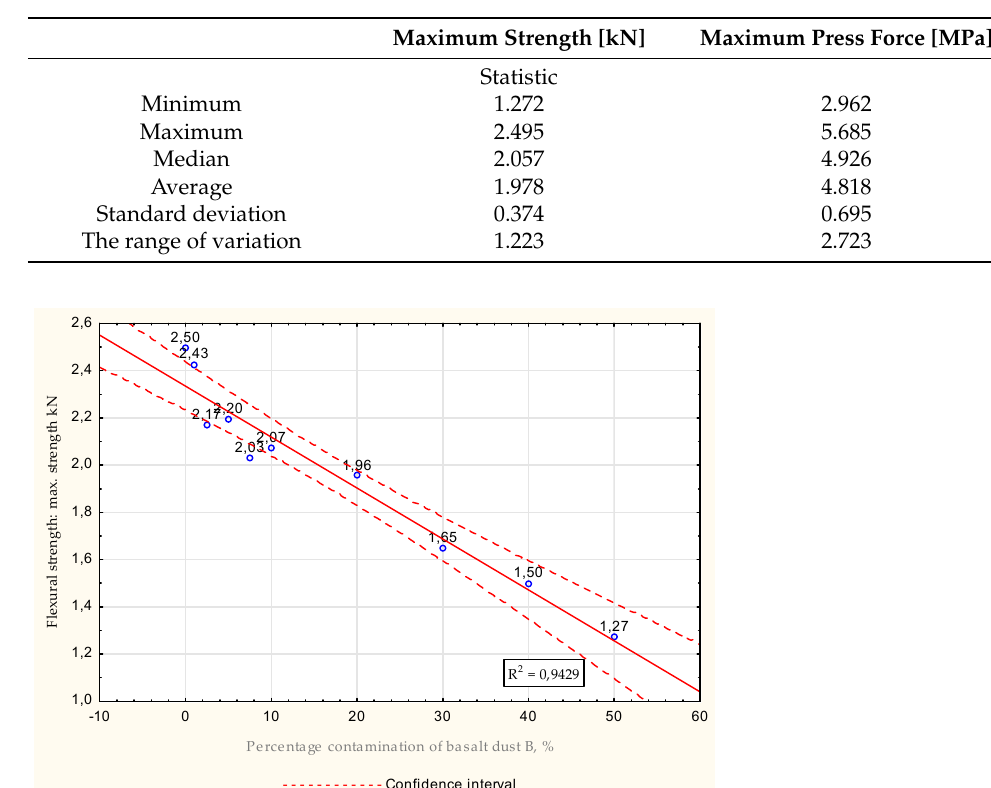
R 2 = 0,9669 Figure 36. Average values obtained during flexural strength tests after 28 days for water − mix ratio = 0.7, maximal pressure. For water–mix ratio 0.7, flexural strength values once again showed a trend of de- creasing strength. For both max. strength and max. pressure, the lowest value was ob- tained for the mixture with 50% basalt dust. Results were about 49% lower for max. strength and about 48% lower for max. pressure compared to those of the base slurry. For the remaining samples, the reduction in values varied between 0.2% and 40%.